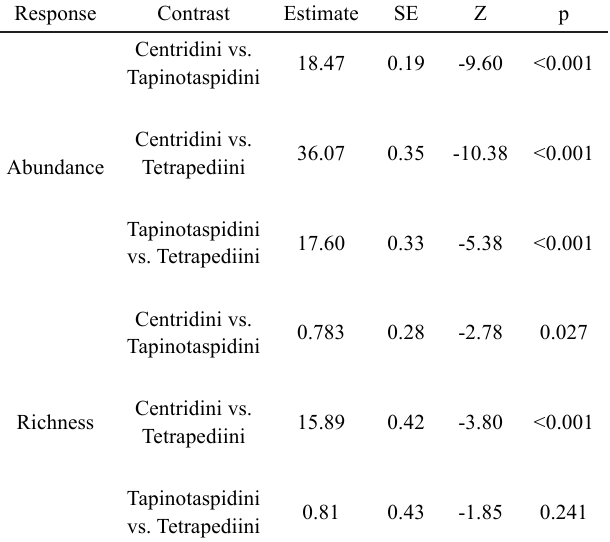
Table 5 . Planned contrasts for slope differences between tribes. Each slope was calculated from the relationship between bee abundance or bee richness (response variables) and plant abundance (explanatory variable). Estimated values indicate the difference in slope values between the first and the second tribe mentioned in each